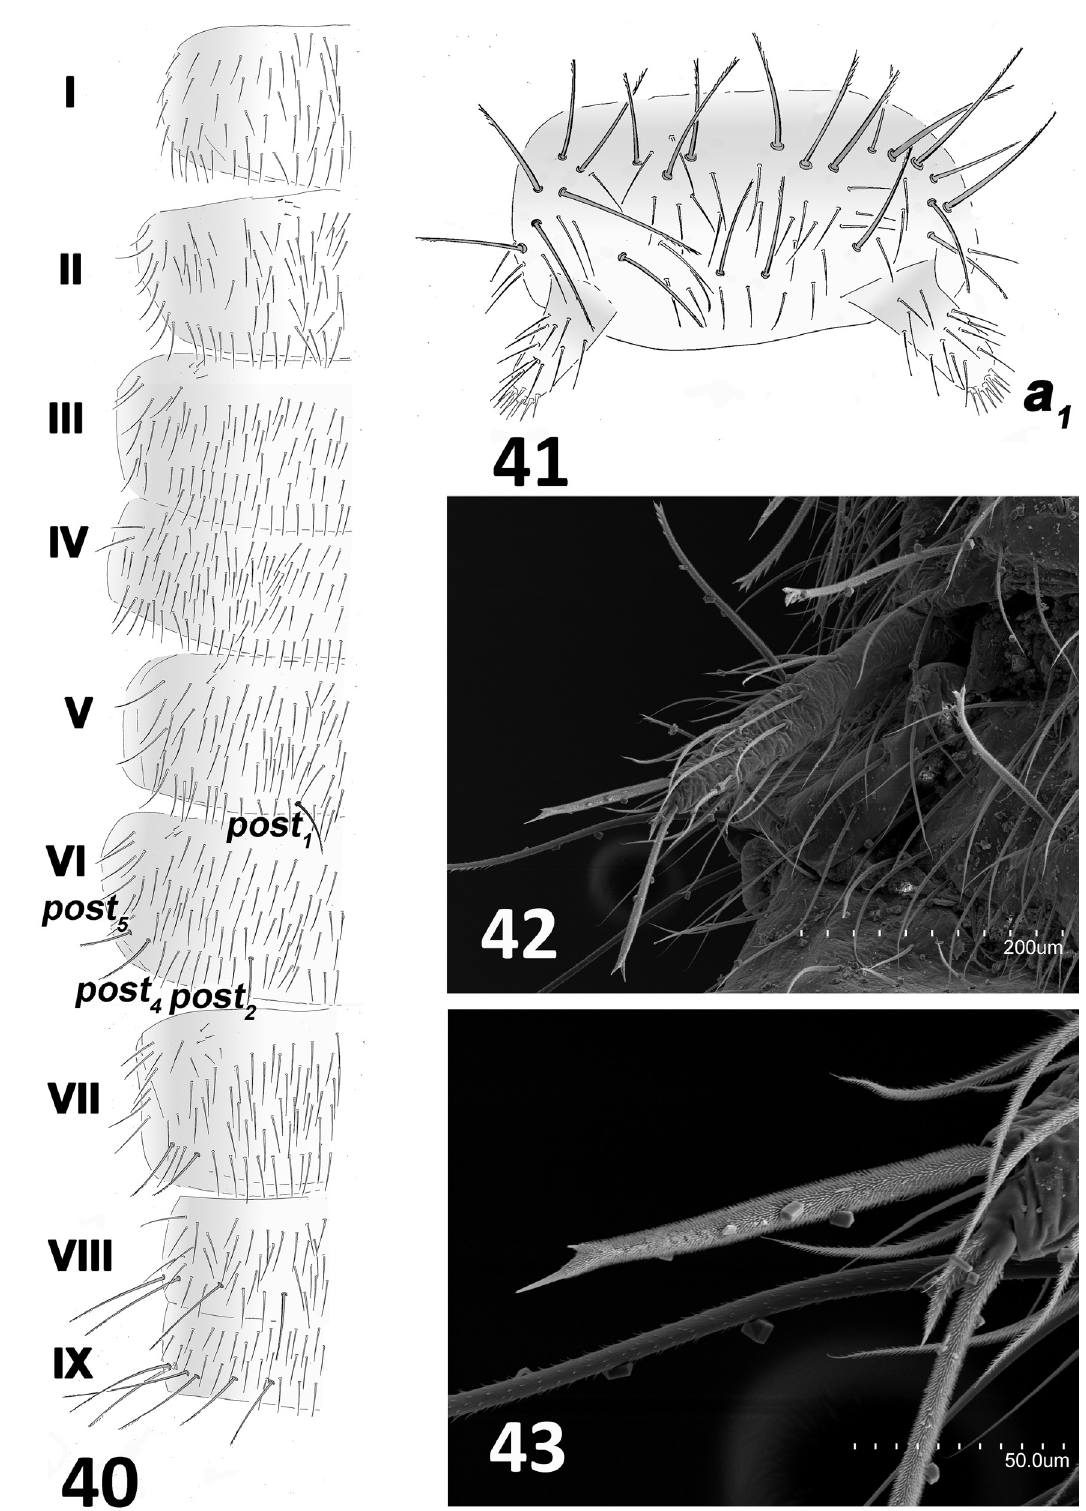
Figs 40‒43. Hubeicampa melissa Sendra & Lips gen. et sp. nov. 40 . Urotergites I‒VII and abdominal segment IX, left side, holotype (MZB (MCNB) 2020-1162). 41 . First urosternite of a female, holotype (MZB (MCNB) 2020-1162, with glandular a setae. 42 . Stylus, right fifth urosternite. 43 . Detail stylus, 1 right fifth